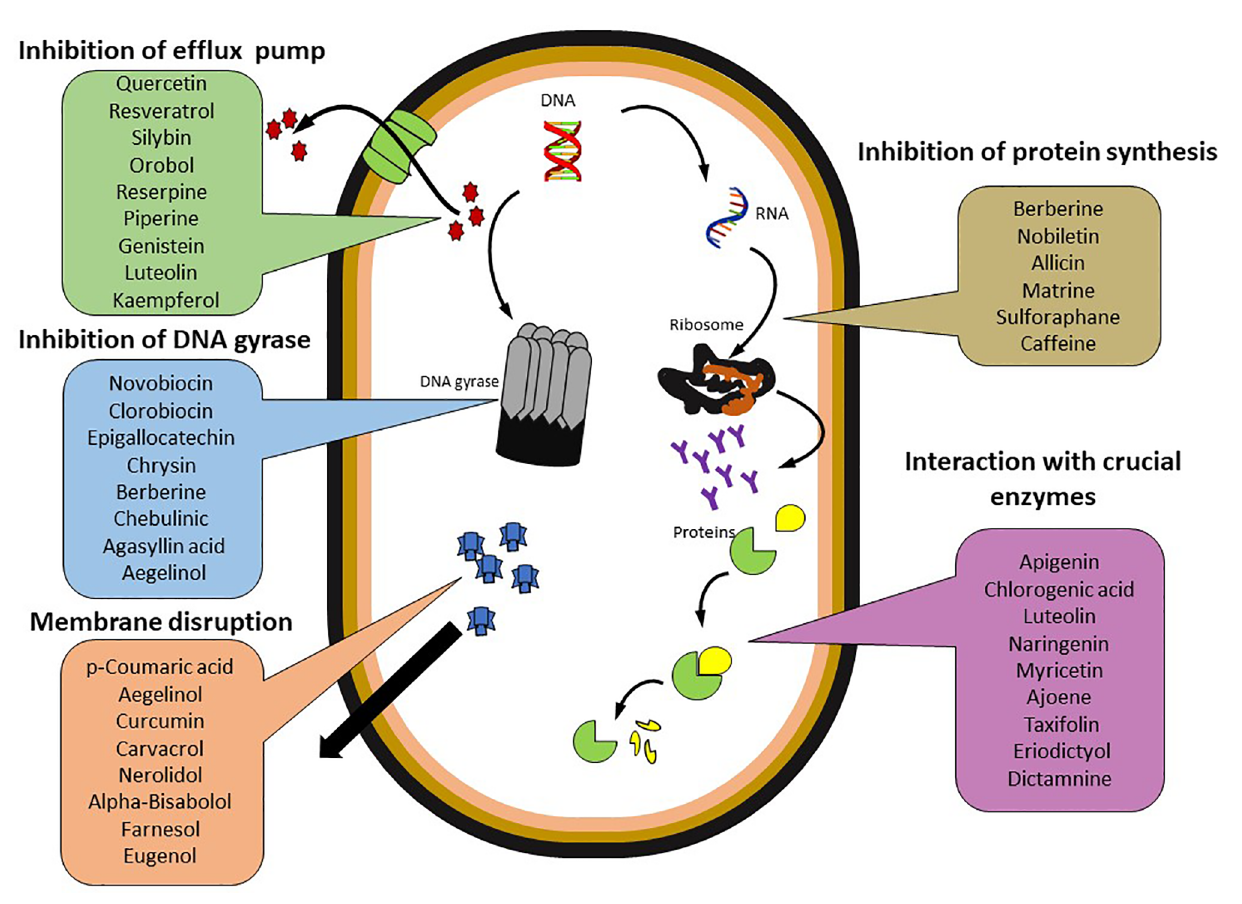
FIGURE 3 | Promising phytochemicals against Multi Drug Resistant